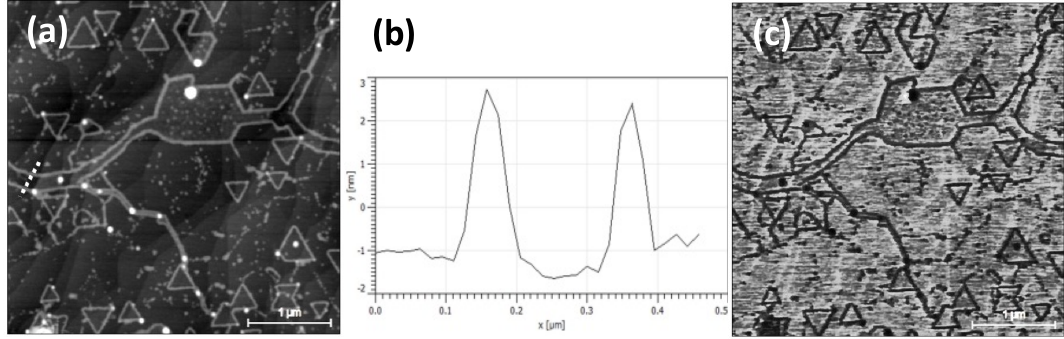
Figure 2. PF-QNM data obtained on the same sample of Figure 1. Specifically, ( a ) morphology channel; ( b ) height profile of the dotted line drawn in ( a ); ( c ) adhesion channel. Height values: triangular terraces, 0.5 ± 0.2 nm; crystal edges, from 2 to 4 nm; bumps, from 10 to 30 nm.